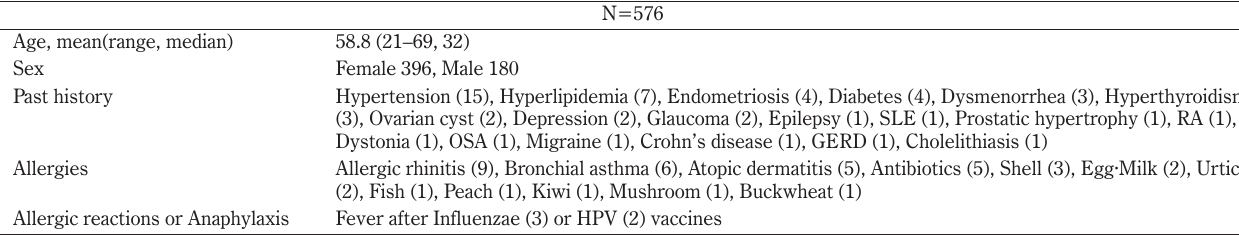
Table 1 Characteristics of subjects before vaccinations Age, mean(range,